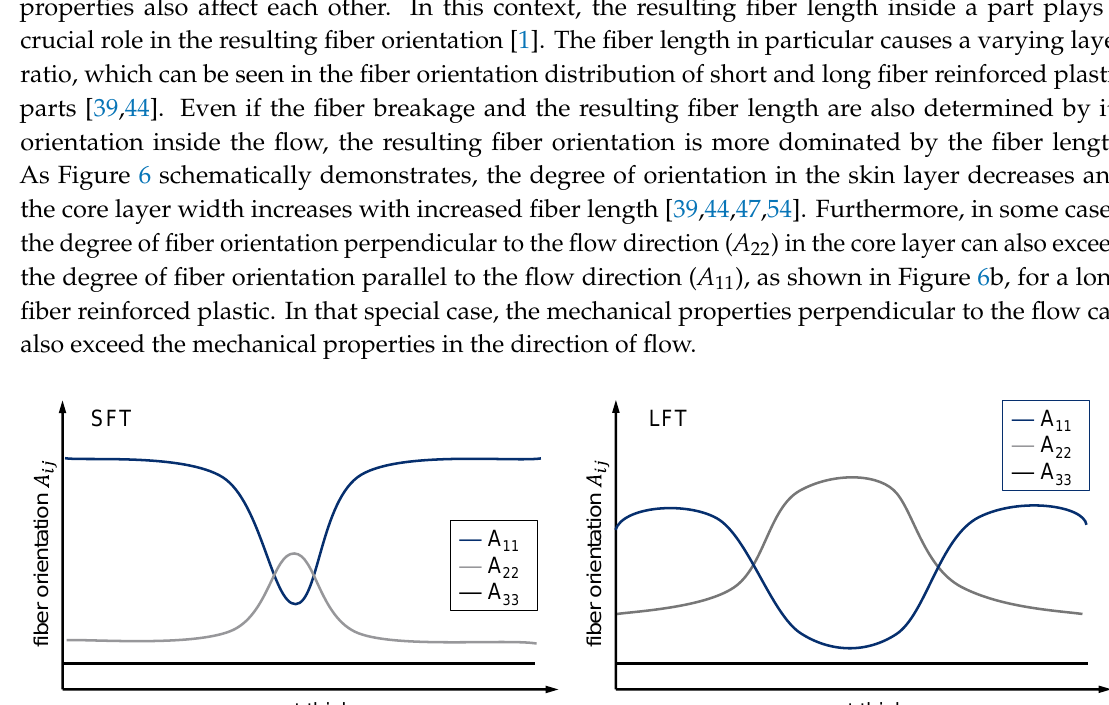
norm. part thickness